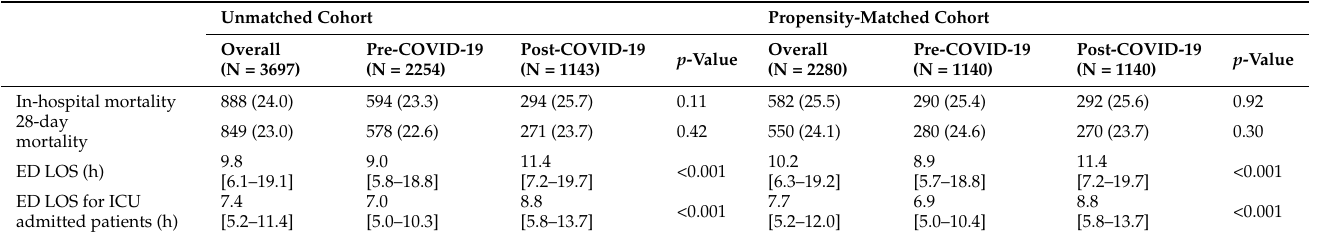
Table 2. Primary and secondary